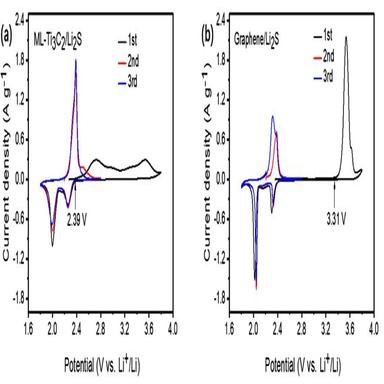
(a) Cyclic voltammograms of ML-Ti3C2/Li2S electrode, (b) cyclic voltammograms of ML-Ti3C2/Li2S electrode.